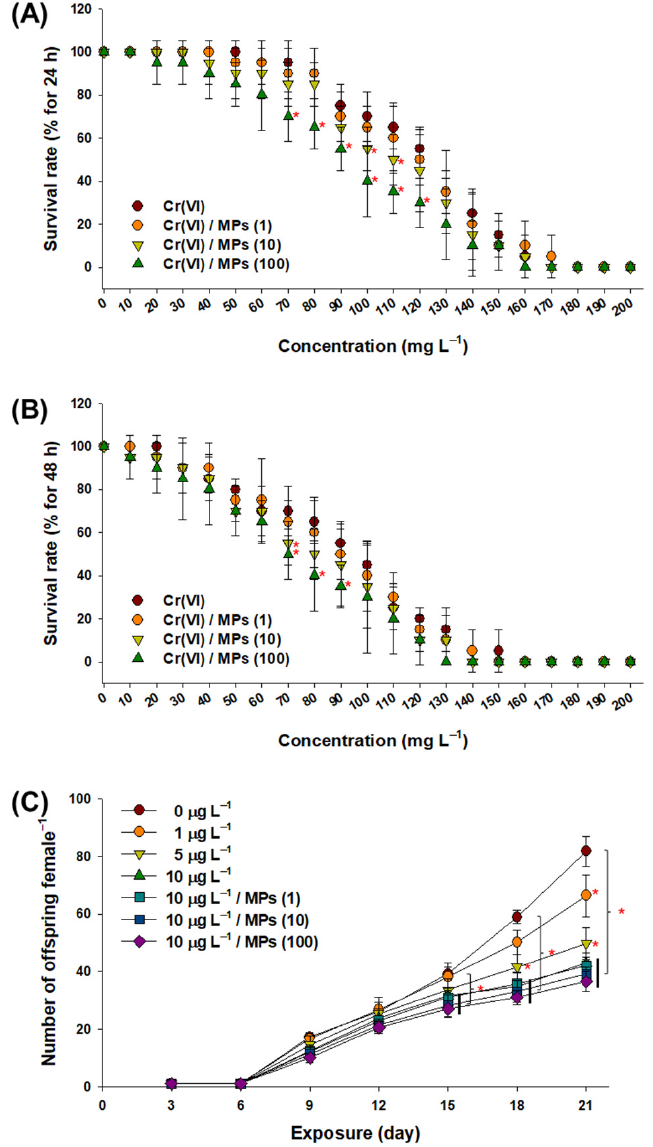
Figure 2. Results of acute toxicity and the chronic reproductive impact of Cr(VI) + MPs on water fleas. Measurement of the survival rate of daphnids in response to Cr(VI) (0–200 µ g L − 1 at 10 µ g L − 1 intervals) and the combination of Cr(VI) and 1 µ m MPs (1, 10, and 100 particles L − 1 ) at ( A ) 24 h and ( B ) 48 h. ( C ) Number of live offspring per female following 21 days of exposure to sublethal concentrations of Cr(VI) (0–10 µ g L − 1 ) and the combination of Cr(VI) and 1 µ m MPs (1, 10, and 100 particles L − 1 ). Data are presented as mean ± standard deviation (S.D.) of three groups. An asterisk (*) indicates significant difference between the exposed groups for each concertation or day ( p <